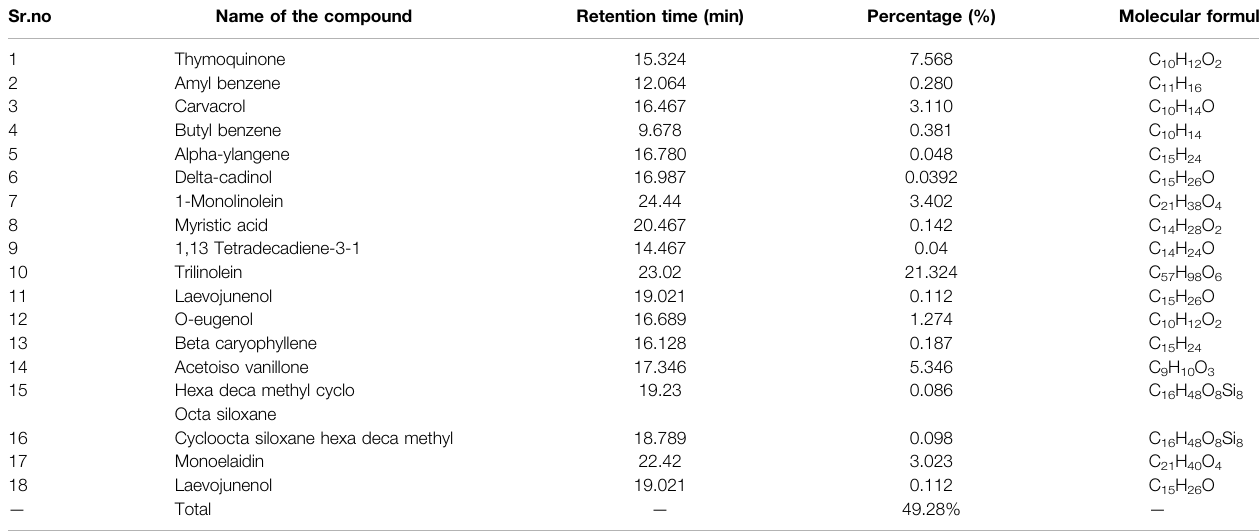
TABLE 7 | Identi fi ed compounds by GC in N. sativa ethanolic extract.